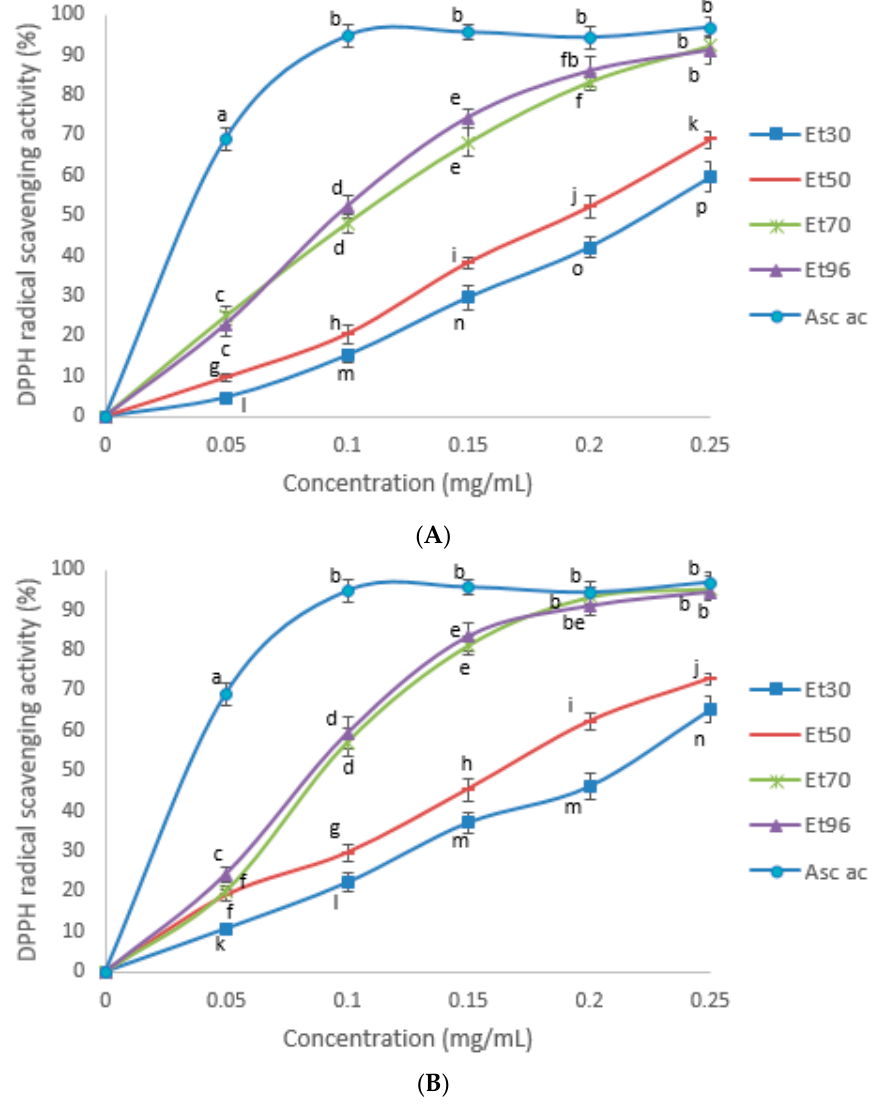
Figure 3. DPPH radical scavenging activity (%) of the ascorbic acid and seed extracts of FSV ( A ) and FWV ( B ) at different ethanol concentrations in the extract solutions. Means not bearing a same letter are significantly different ( p < 0.05). Asc ac = Ascorbic acid. Treatments: Et30 = extract with 30% ethanol; Et50 = extract with 50% ethanol; Et70 = extract with 70% ethanol; Et96 = extract with 96% ethanol.